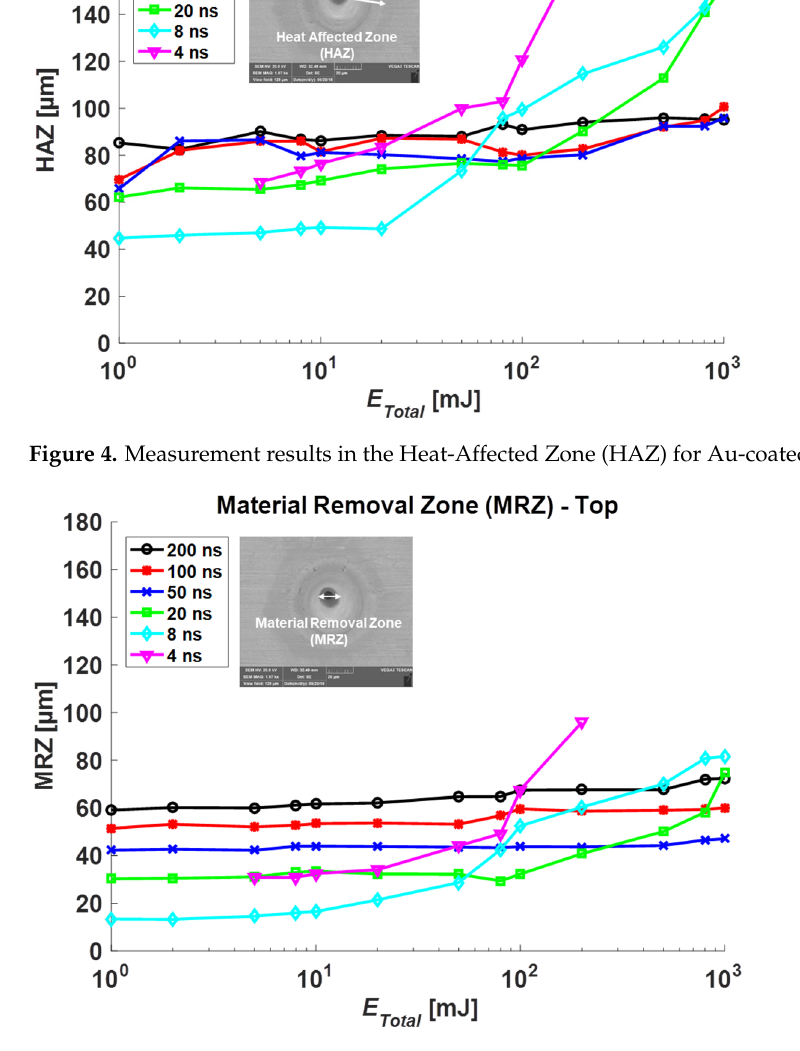
Figure 5 . Measurement results in the top surface of Material Removal Zone (MRZ top) for Au-coated specimens.